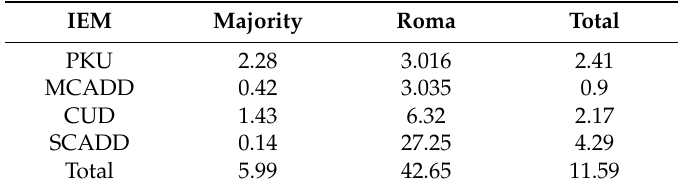
Table 5. Prevalence (n to 104) of the most frequent IEMs in total newborn population and after the